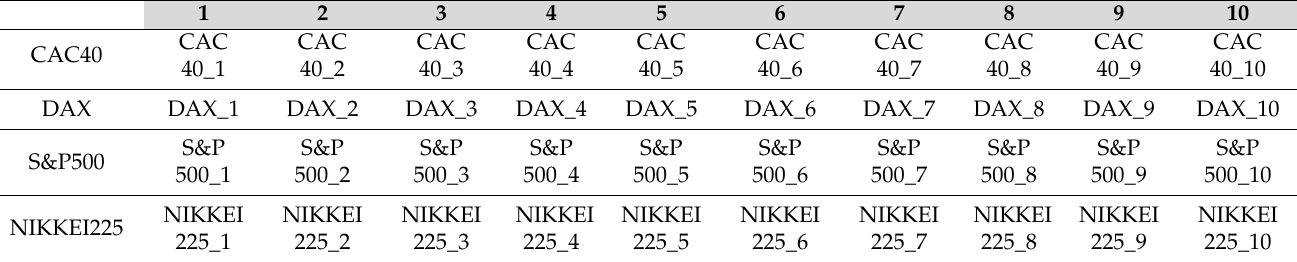
Table 1. The 10 lag features extracted from each global stock index in the past 10